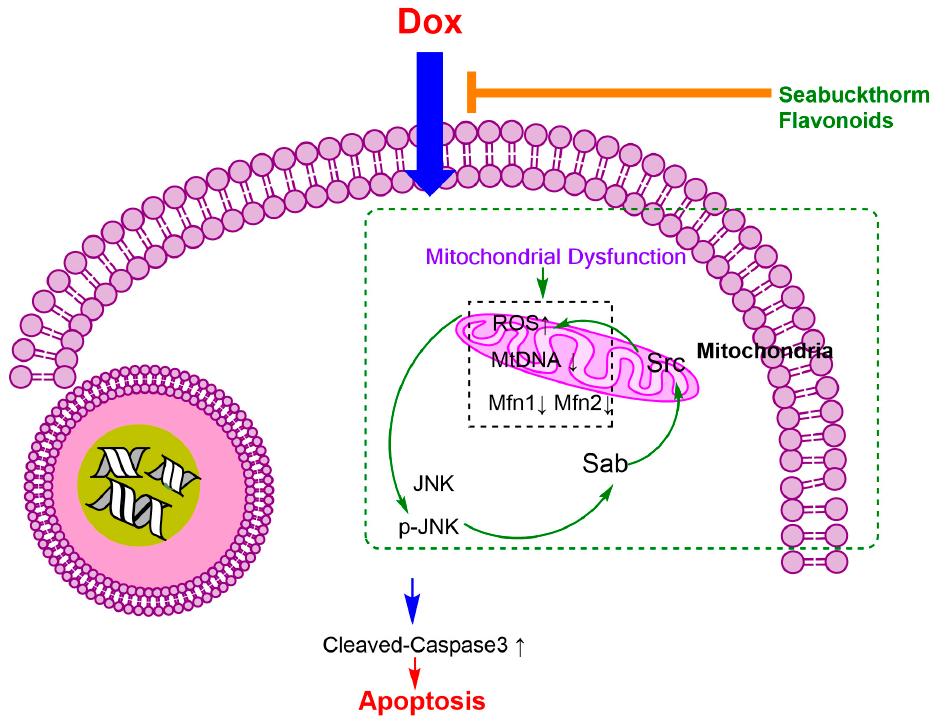
Figure 10. Possible signaling mechanism